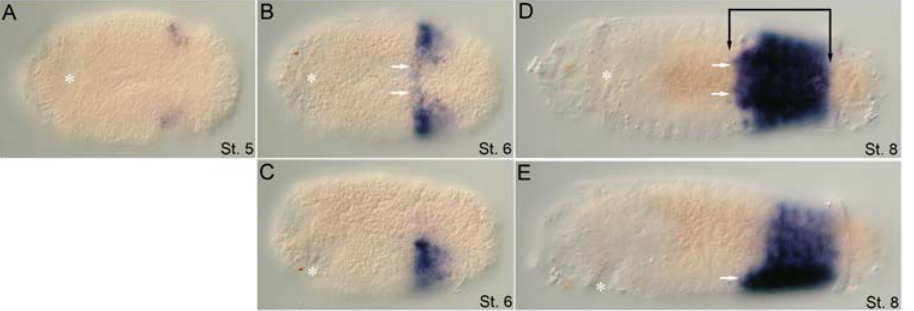
Figure 10. Larval expression of CapI-lox4 . Anterior is to the left for all panels. Stages indicated at bottom right of each panel. (A), (B), and (D) show ventral views; (C) and (E), lateral views with ventral down. Asterisk marks position of the mouth. (A, B) Onset of CapI-lox4 expression at early stage 5 in a ventro-lateral ectodermal domain in the posterior mid-body. (C, D) By stage 6, expression crosses the midline in T7 and connects the two ventro-lateral domains. (E, F) CapI-lox4 expression is most prominent at stage 8 and includes T7 to T9, all of the abdominal segments, and the growth zone (black bracket). White arrows point to VNC expression (white arrows).